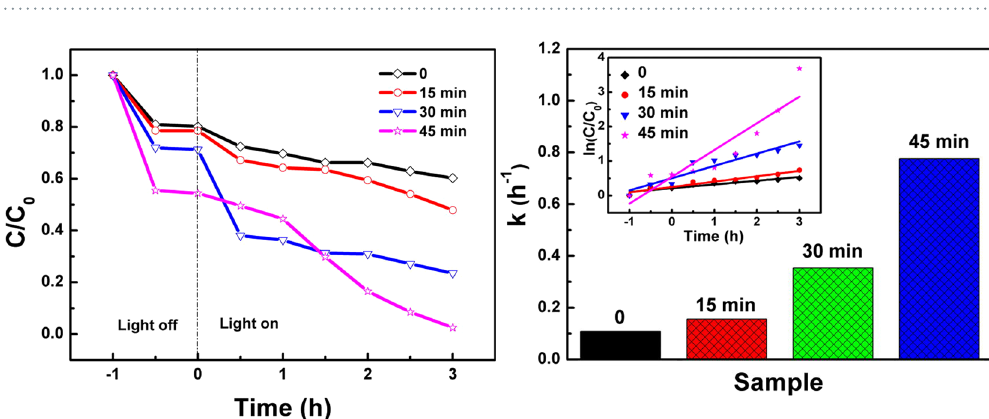
Fig. 8. ( a ) Photodegradation efficiencies and ( b ) First-order degradation rate constant of MO in the presence of Bi 2 Fe 4 O 9 with different etching times under UV-light